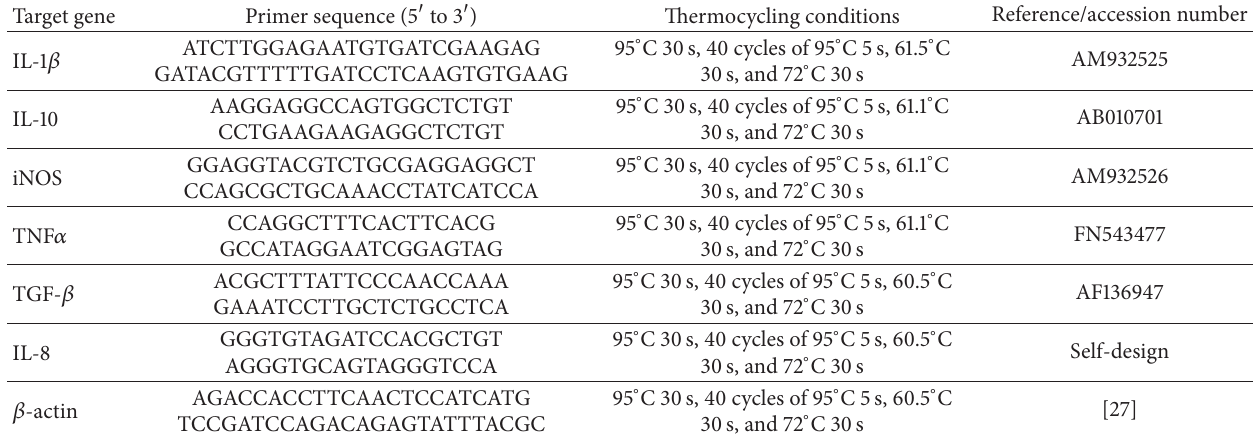
Table 1: Real-time primer sequences and thermocycling